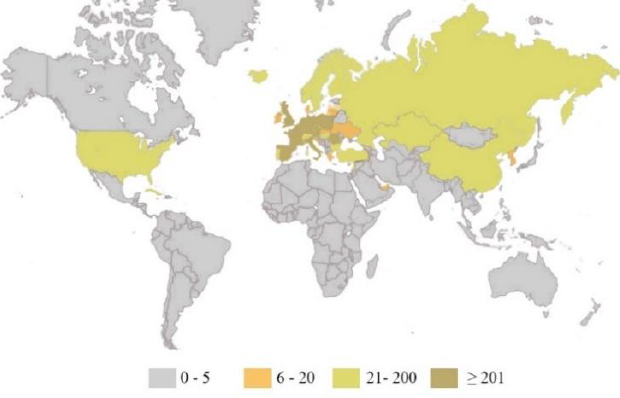
Fig. 2. Countries with BREEAM certificates in the world and the number range [Created by the authors based on BREEAM